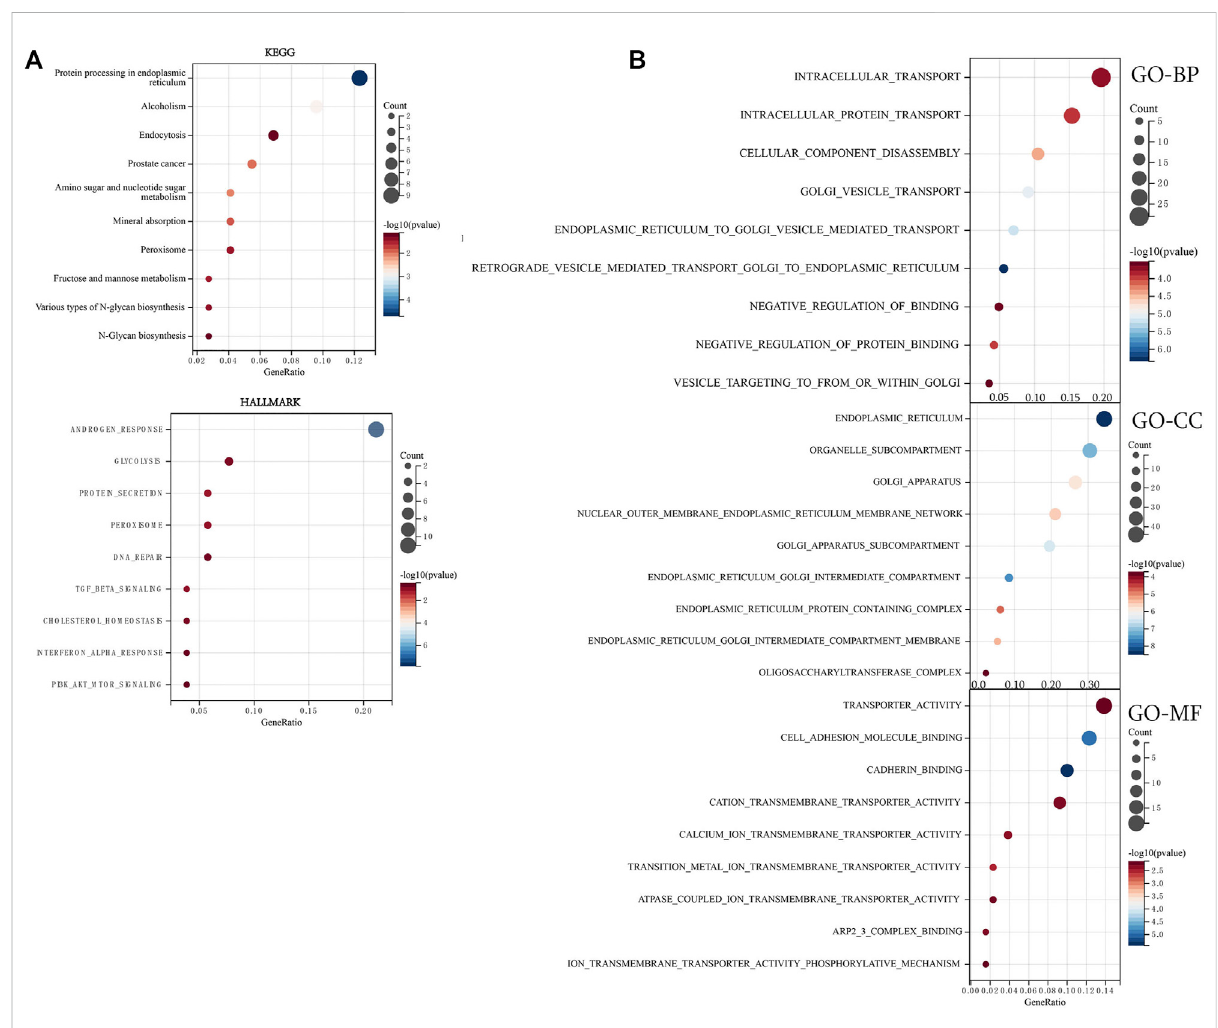
FIGURE 7 Enrichment analysisoftop 200AGTRAP-relatedgenes. (A) KEGG enrichment analysis ofAGTRAP-related genes. (B) GO enrichmentanalysisof AGTRAP-related